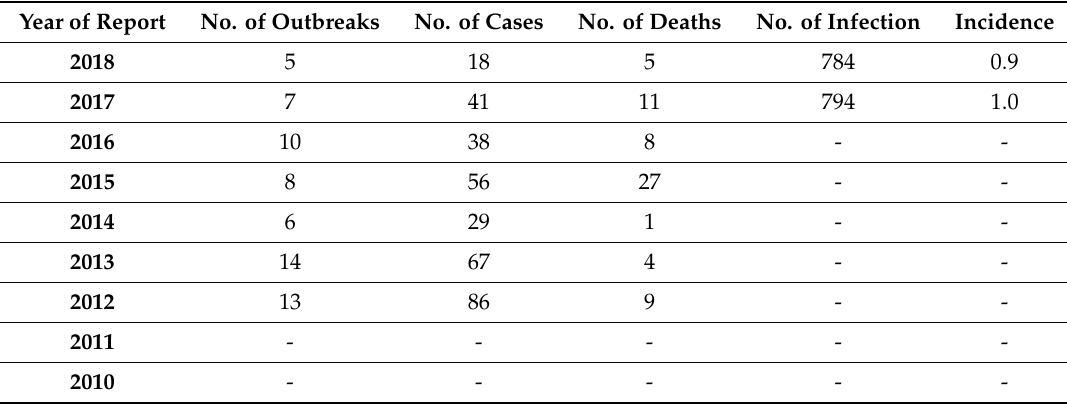
Table 2. Number of the nosocomial outbreaks of carbapenem-non-susceptible Acinetobacter spp.